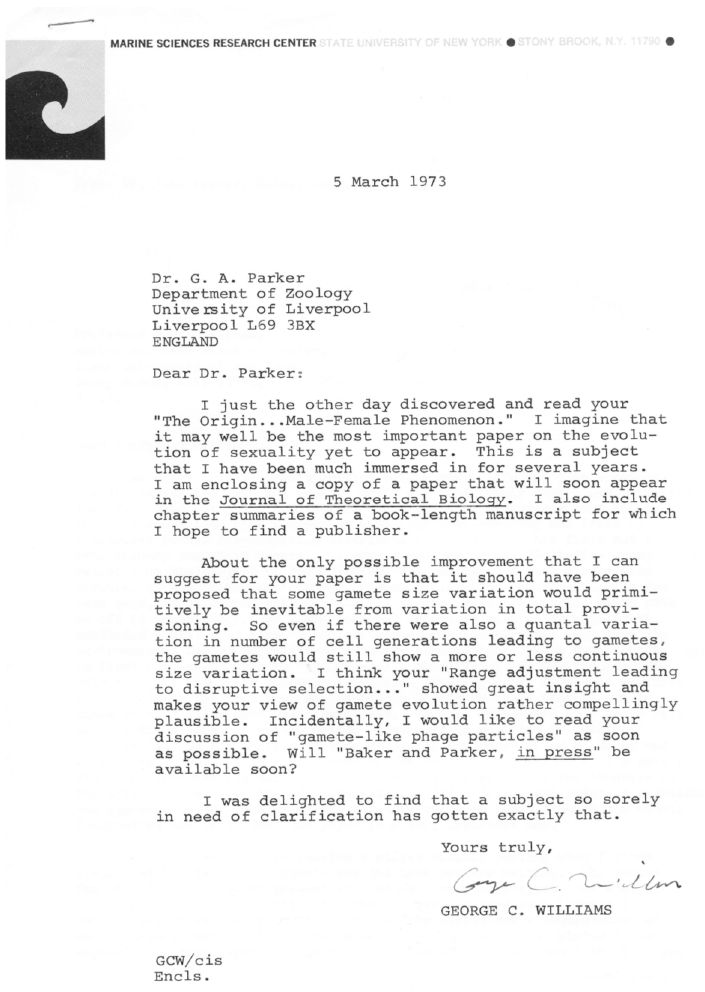
Figure 4. The 1973 letter from George